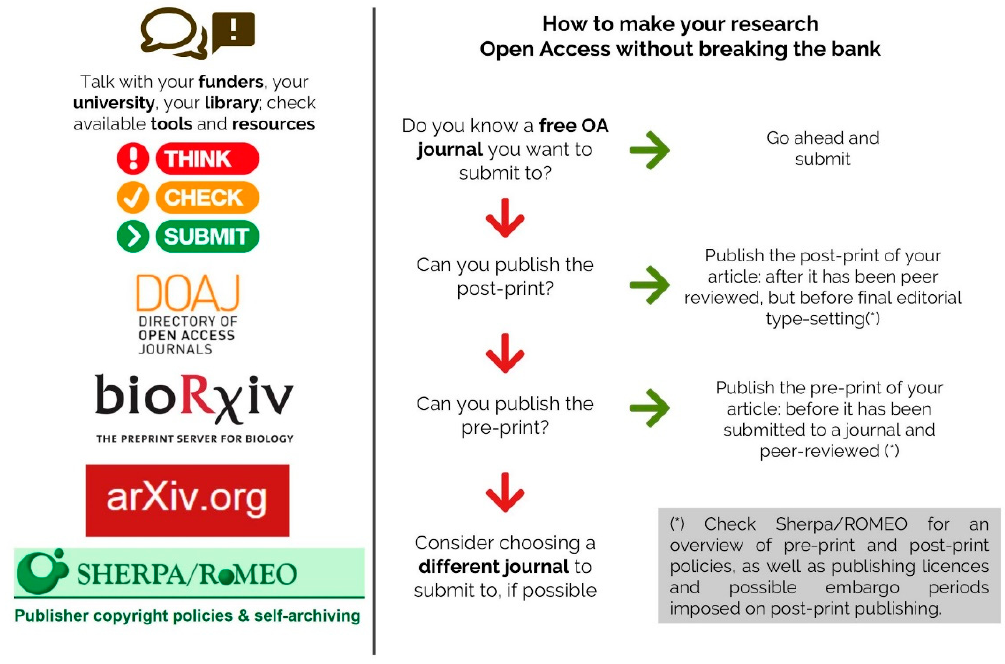
Figure 4. Some steps allowing free Open Access publishing for authors (vertical arrows imply ‘no’, and horizontal arrows imply ‘yes’. Inspired by https://figshare.com/collections/How_to_make_your_work_100_Open_Access_for_free_and_legally _multi-lingual_/3943972. 2.8. Topic 8: Are embargo periods on ‘green’ OA needed to sustain